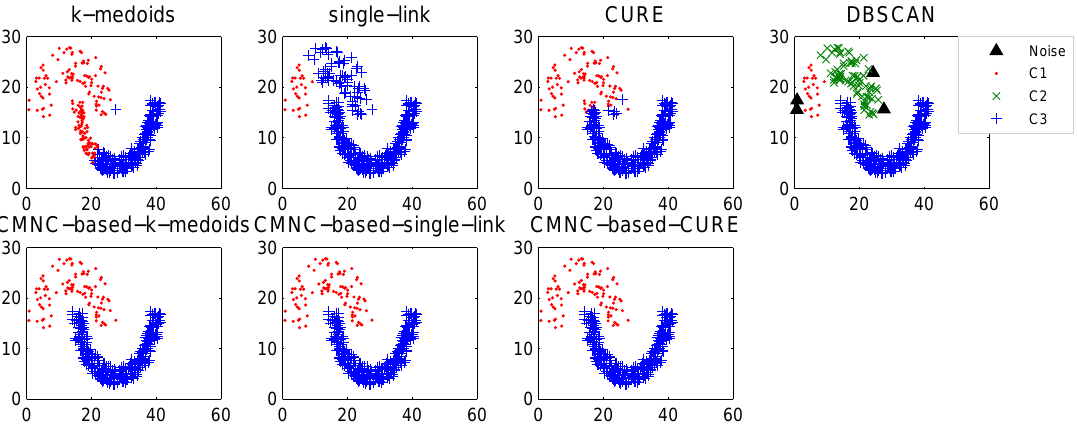
Figure 9. Comparison of clustering results on the “double-moon” dataset.